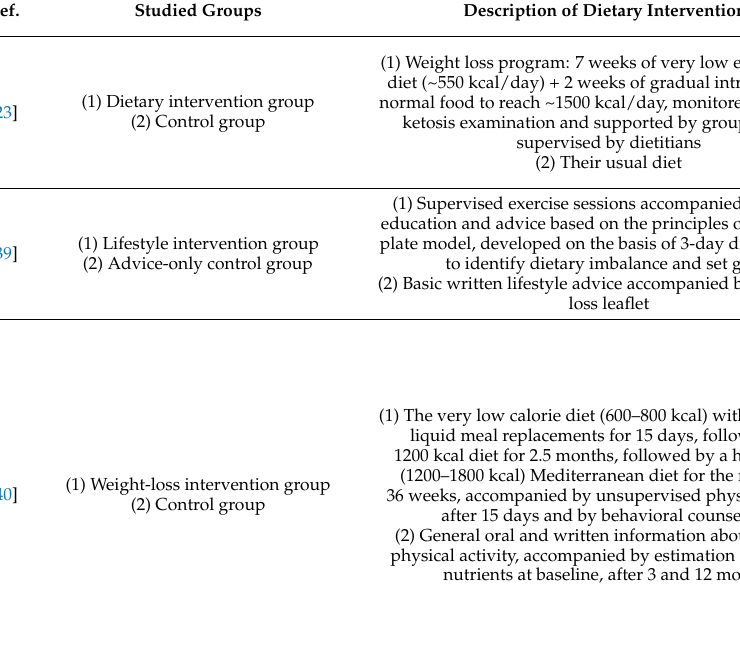
Table 4. Interventions applied within randomized controlled trials included in this study, accompanied by the conclusions of this study for influence of diet therapy.